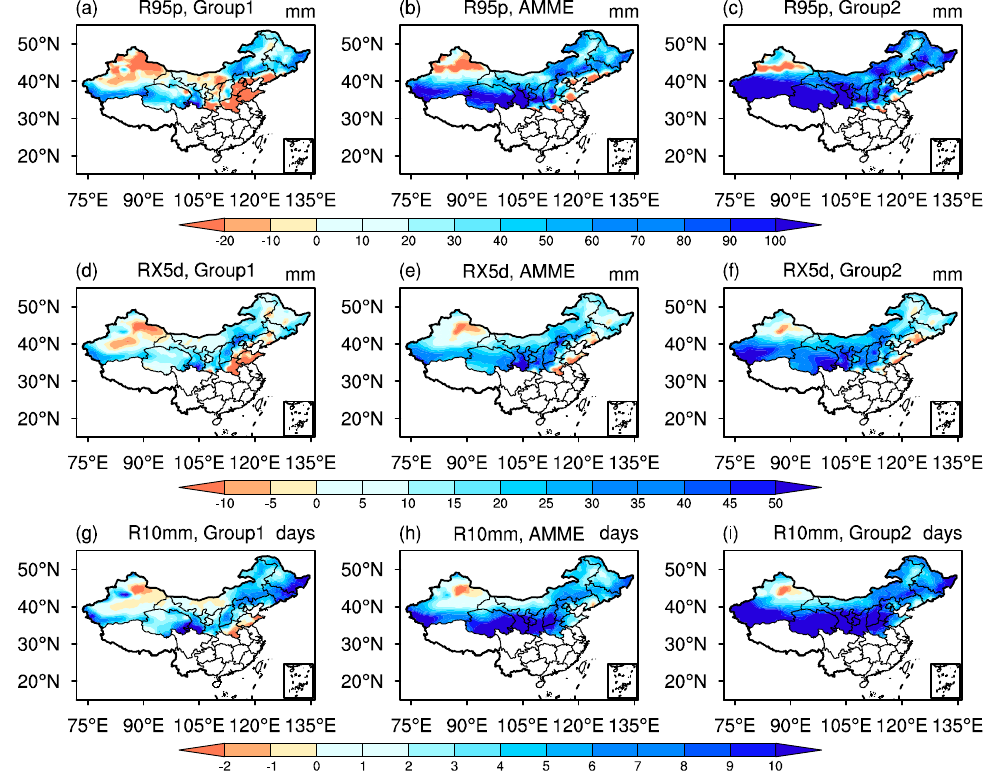
Figure 6. Model biases of three extreme rainfall indices including ( a – c ) R95p, ( d – f ) RX5d, and ( g – i ) R10mm form Group 1, AMME, and Group 2.